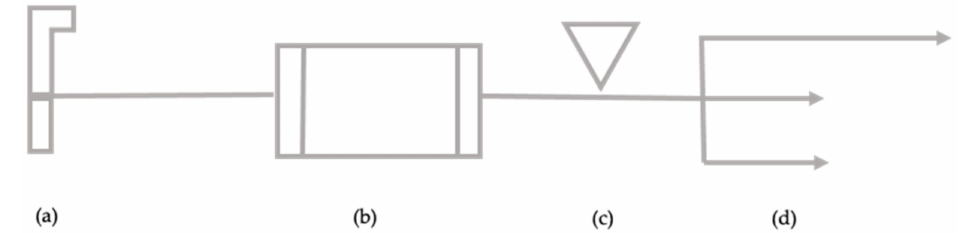
Figure 4. Process diagram of water pipeline from an artesian well. ( a ) Water source—artesian well, ( b ) water storage, ( c ) chlorination, and ( d ) distribution